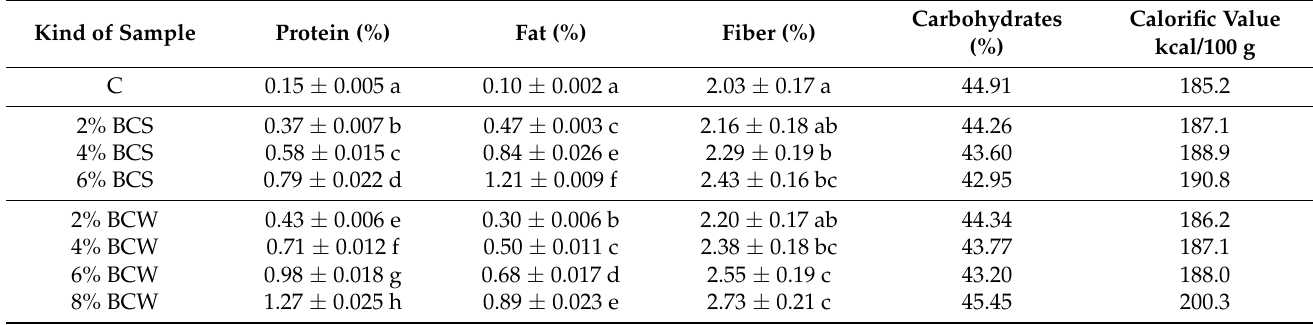
Mean values in the same column marked with different letters are significantly ( α = 0.05) different. Abbreviations: C—control starch bread, BCS—black cumin, BCW—black cumin pressing